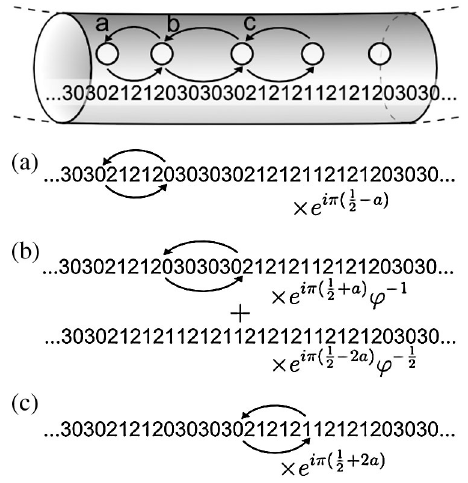
FIG. 10. Graphical representation of the result of exchanging two k ¼ 3 Read-Rezayi quasiholes for three example pairs. Top: A possible state in which five quasiholes could be prepared, labeled by its associated thin torus pattern. The state shown could be a five-quasihole state, in which the 30 strings at either end would continue around the torus, or could be an n -quasihole state for n > 5 , in which the ellipses mask additional domain walls in the thin torus pattern. The results of braiding any pair of quasiholes shown here will be the same in either case. (a) Upon exchange of the indicated quasiholes, the state picks up the phase e i(cid:2) ½ð 1 = 2 Þ(cid:1) a (cid:7) , where a is given by Eq. (166) (with the lower sign correctly describing the conformal block monodromies of the RR trial states). The thin torus pattern, and thus the topological sector of the state, remains unchanged after the exchange, as shown. (b) When the two indicated quasiholes are exchanged the state remains in the same topological sector or transitions into a sector with the linking 30 string changed to a 21 string. The amplitudes for these two possibilities are shown beneath the thin torus patterns for the sectors, where ’ is the golden ratio, Eq. (165). (c) Upon the exchange of the indicated quasiholes, the state picks up the phase e i(cid:2) ½ð 1 = 2 Þþ 2 a (cid:7) . The thin torus pattern, and thus the topological sector of the state, remains unchanged after the exchange, as